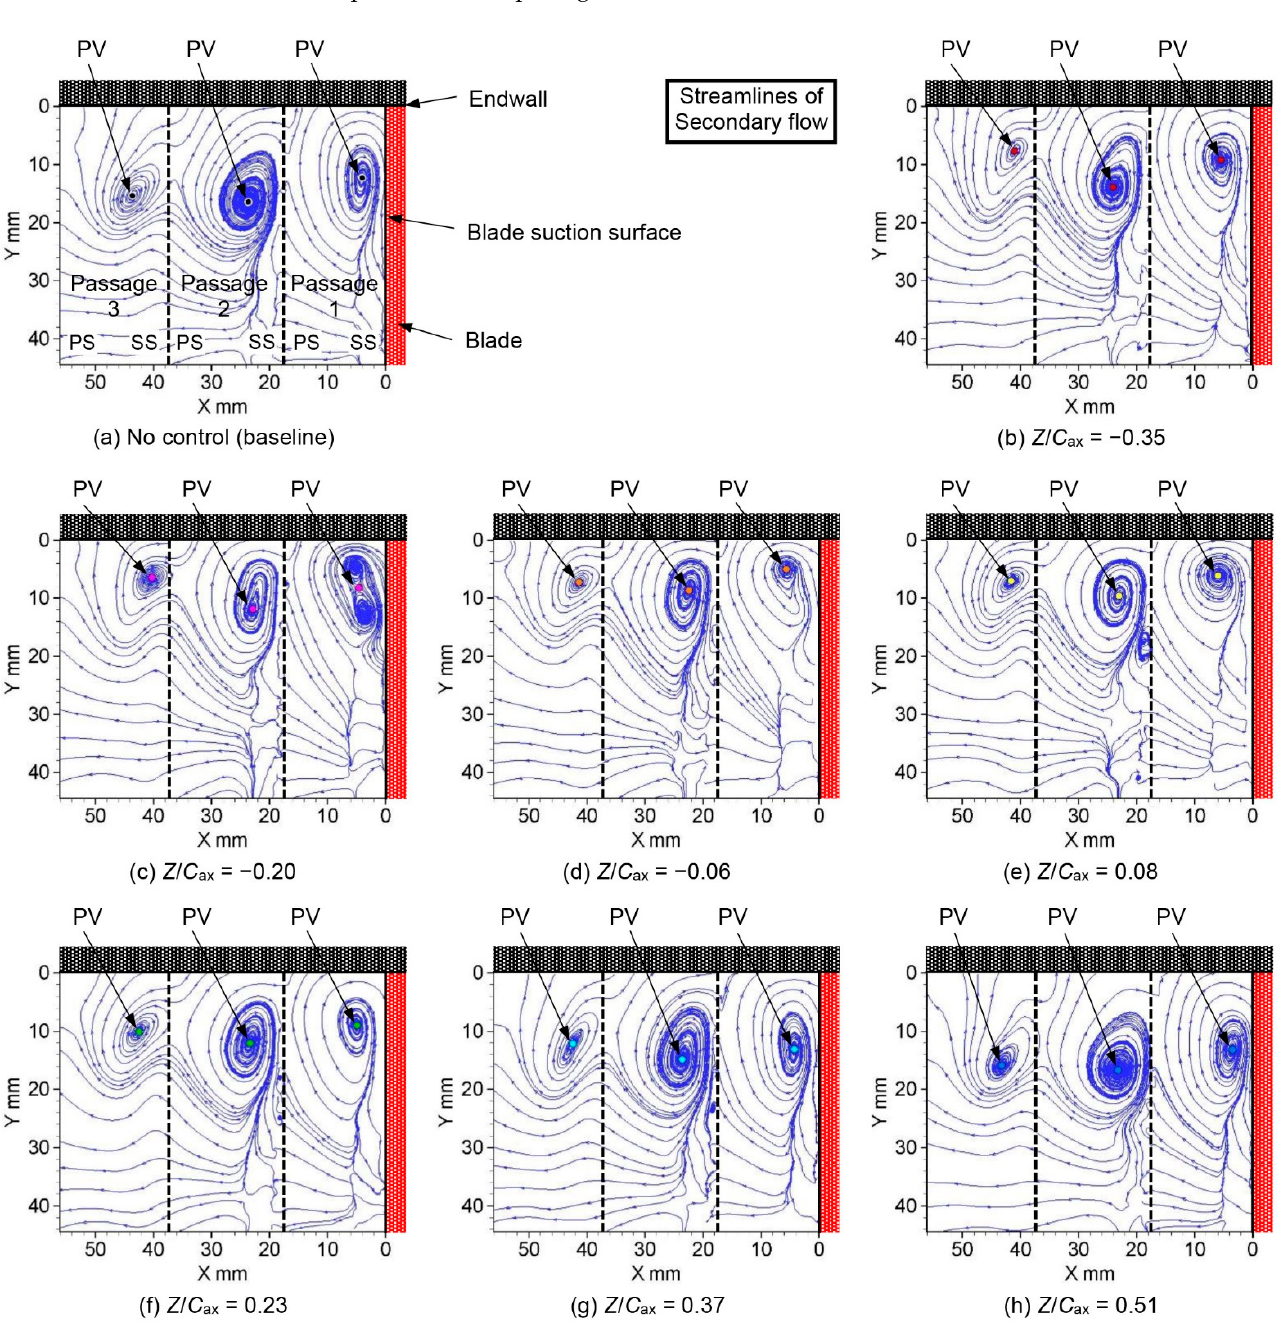
Figure 19. Streamlines of secondary flow at the outlet of the linear turbine cascade at various plasma actuator locations (Re out = 3.7 × 10 4 ).